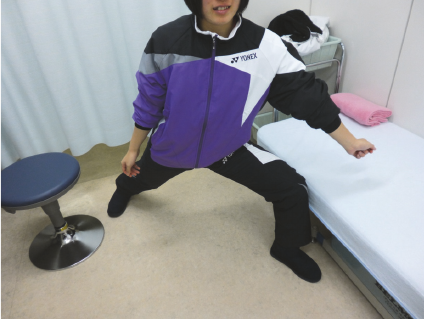
Figure 3: This picture is underhand stroke posture.